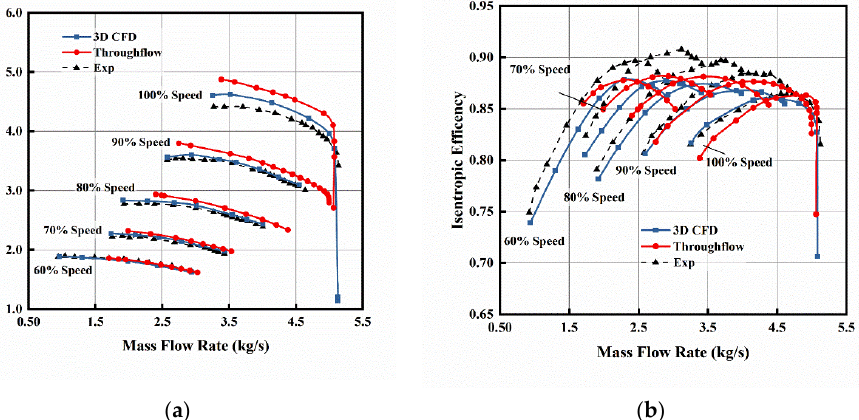
Figure 9. Performance characteristics of the HPCC. ( a ) Total pressure ratio; ( b ) isentropic effi- ciency. Table 4. Contributions of different losses for the HPCC case at 100%